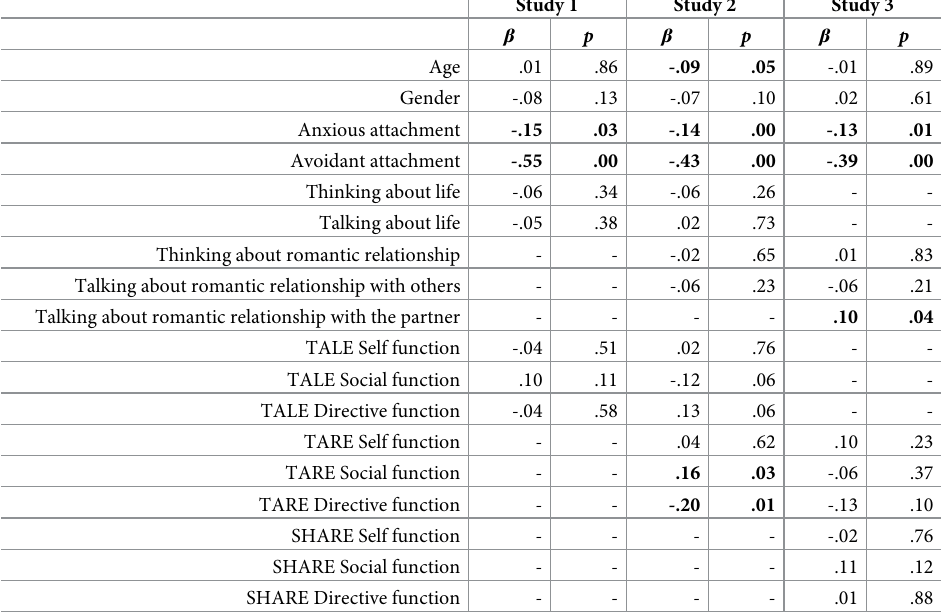
Table 3. Regression results for intimacy across studies.